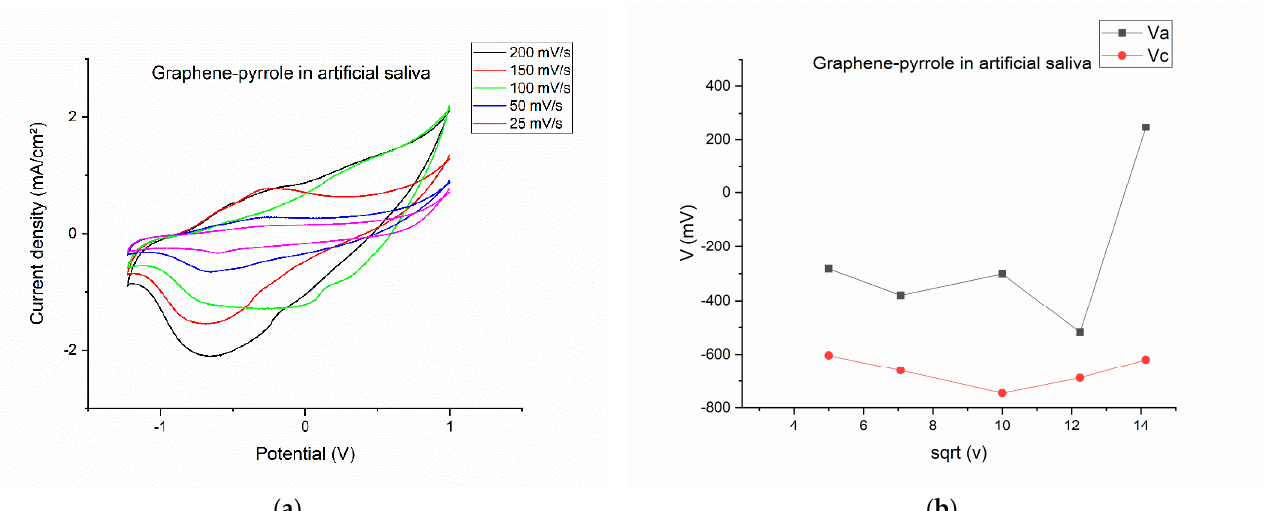
Figure 1. Electropolymerization results for the graphene–pyrrole composite: ( a ) the voltammogram of each of the 20 cycles of the polymerization procedure; ( b ) the total charge exchanged in the polymerization process as function of the number of cycles.